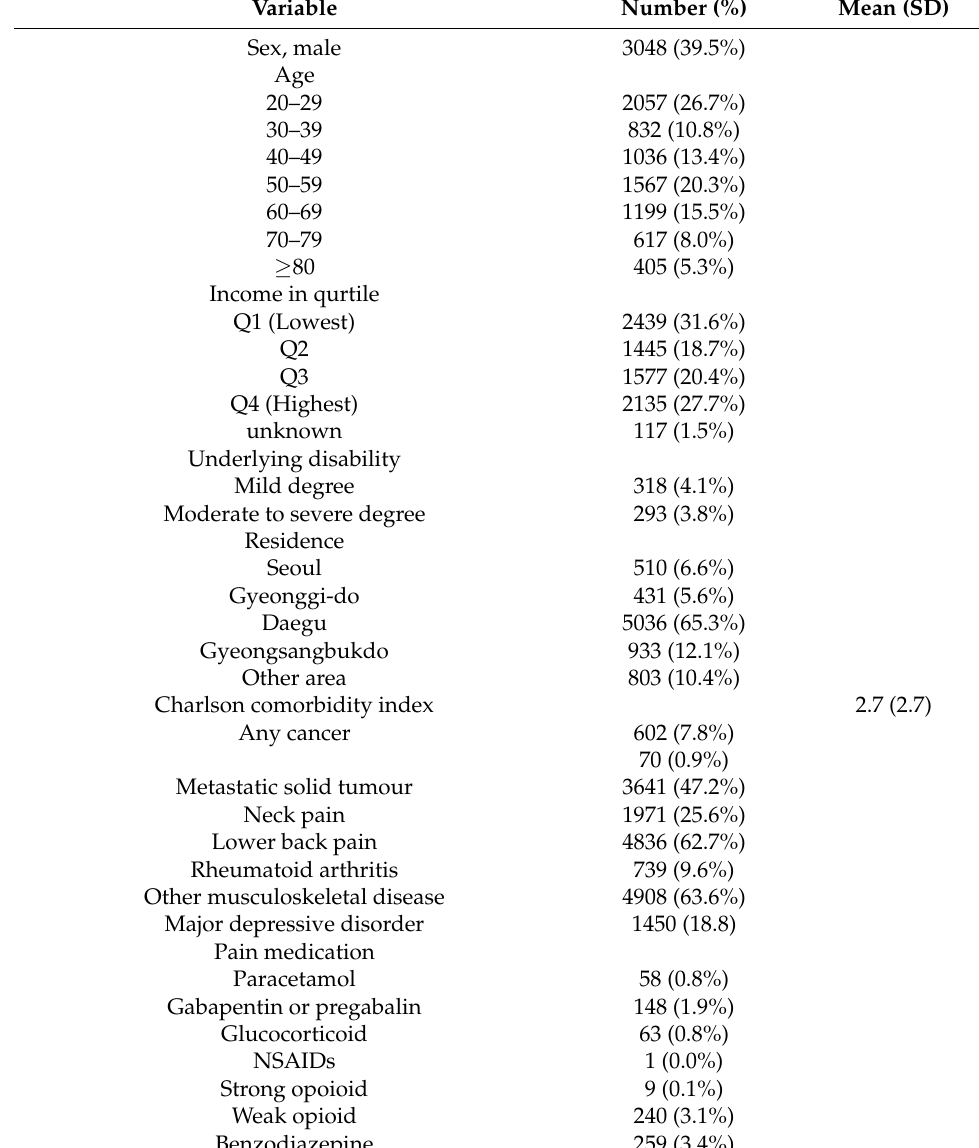
Table 1. Baseline characteristic of COVID-19 patients in South Korea ( n =